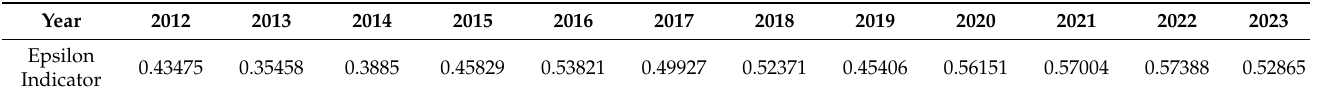
Table A5. Epsilon for the EBM in each year.